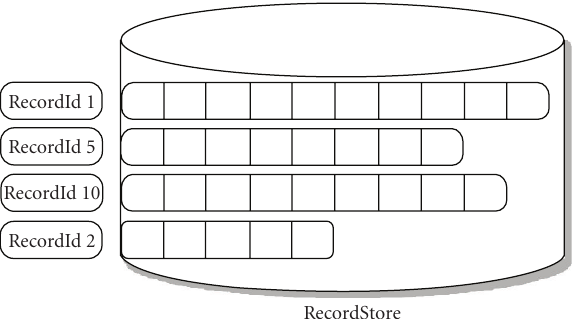
Figure 2: The record management